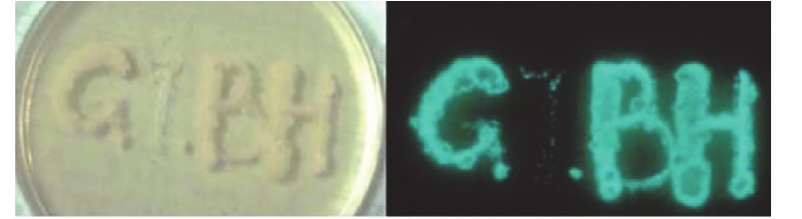
Fig 2. Photograph of the more stable, selectable marker-free, autoluminescent BCG (UABCG).